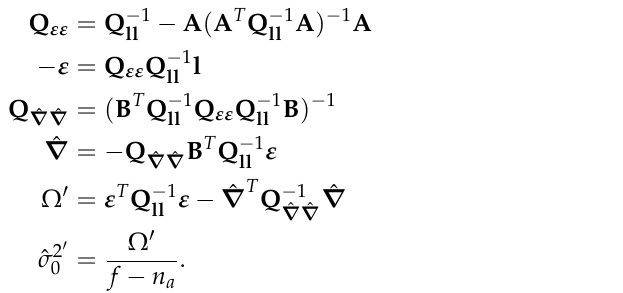
1 , u k + 1 ] × [ v l 1 , v l + 1 ] ( a = 1) of the surface point − −